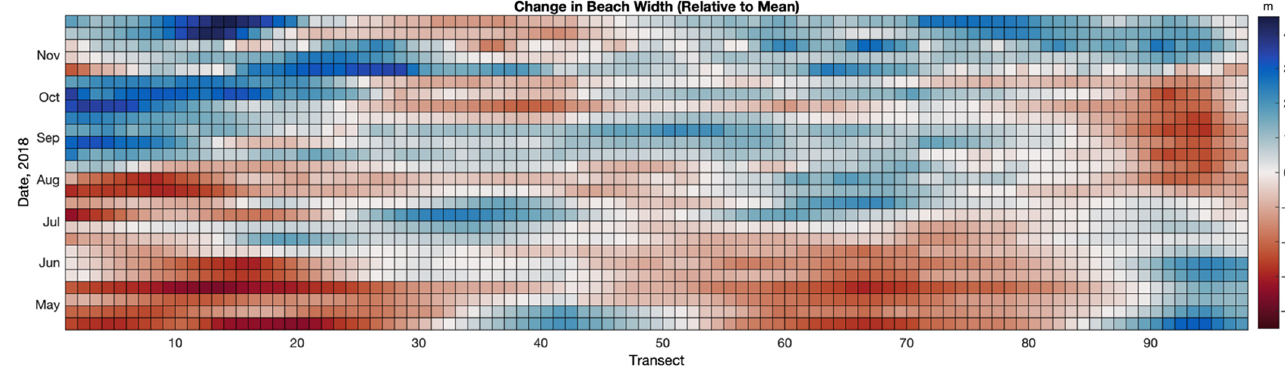
Figure 7. The above figure represents differences from mean beach width for each transect across the DEM time series. Each grid cell corresponds to one transect (x-axis) on a particular survey date (y-axis), while the colors correspond to widths narrower than the mean (red) and widths wider than the mean (blue). The first survey is represented by the bottom row, and subsequent surveys are represented by each row above thereafter. For spatial reference with Figure 1, Transect 0 is represented by the leftmost column. Most transects early in the time series were narrower than their means, but this pattern gradually shifted during the second half of the survey period as beach width increased.